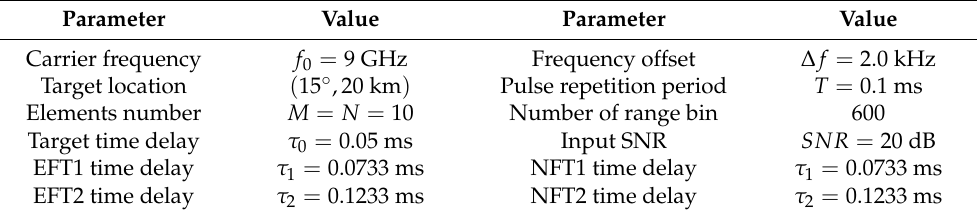
Table 1. Simulation parameters setting table.